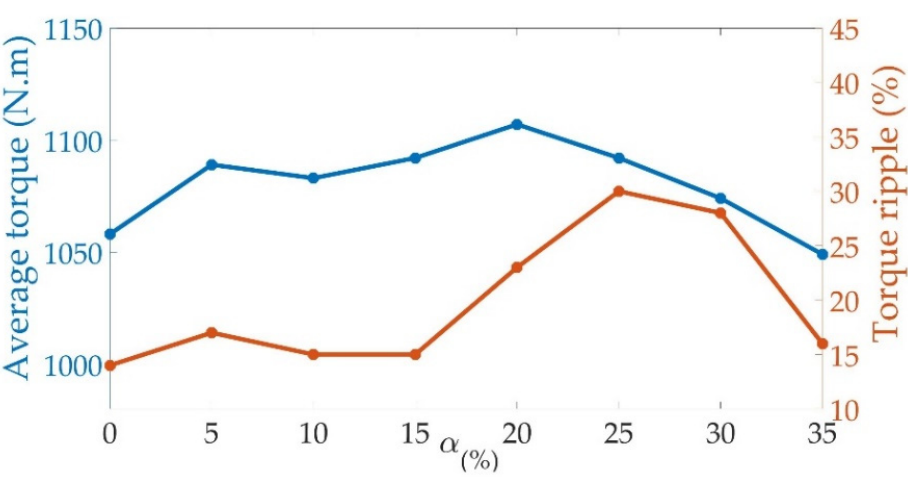
Figure 17. Average torque and torque ripple for different ratios α ( β = 50%).